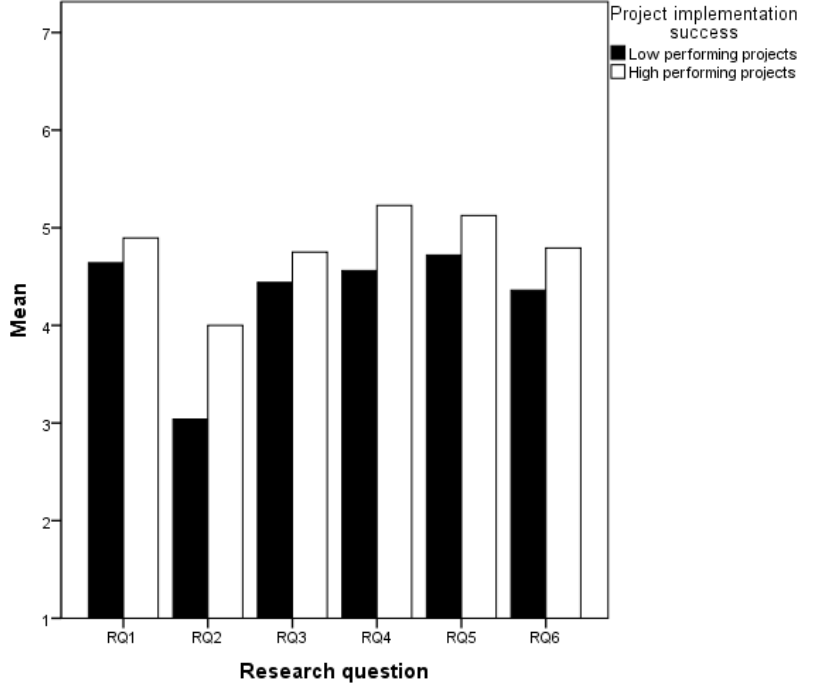
Figure 2. Graphical representation of mean differences of studied groups for each research question.